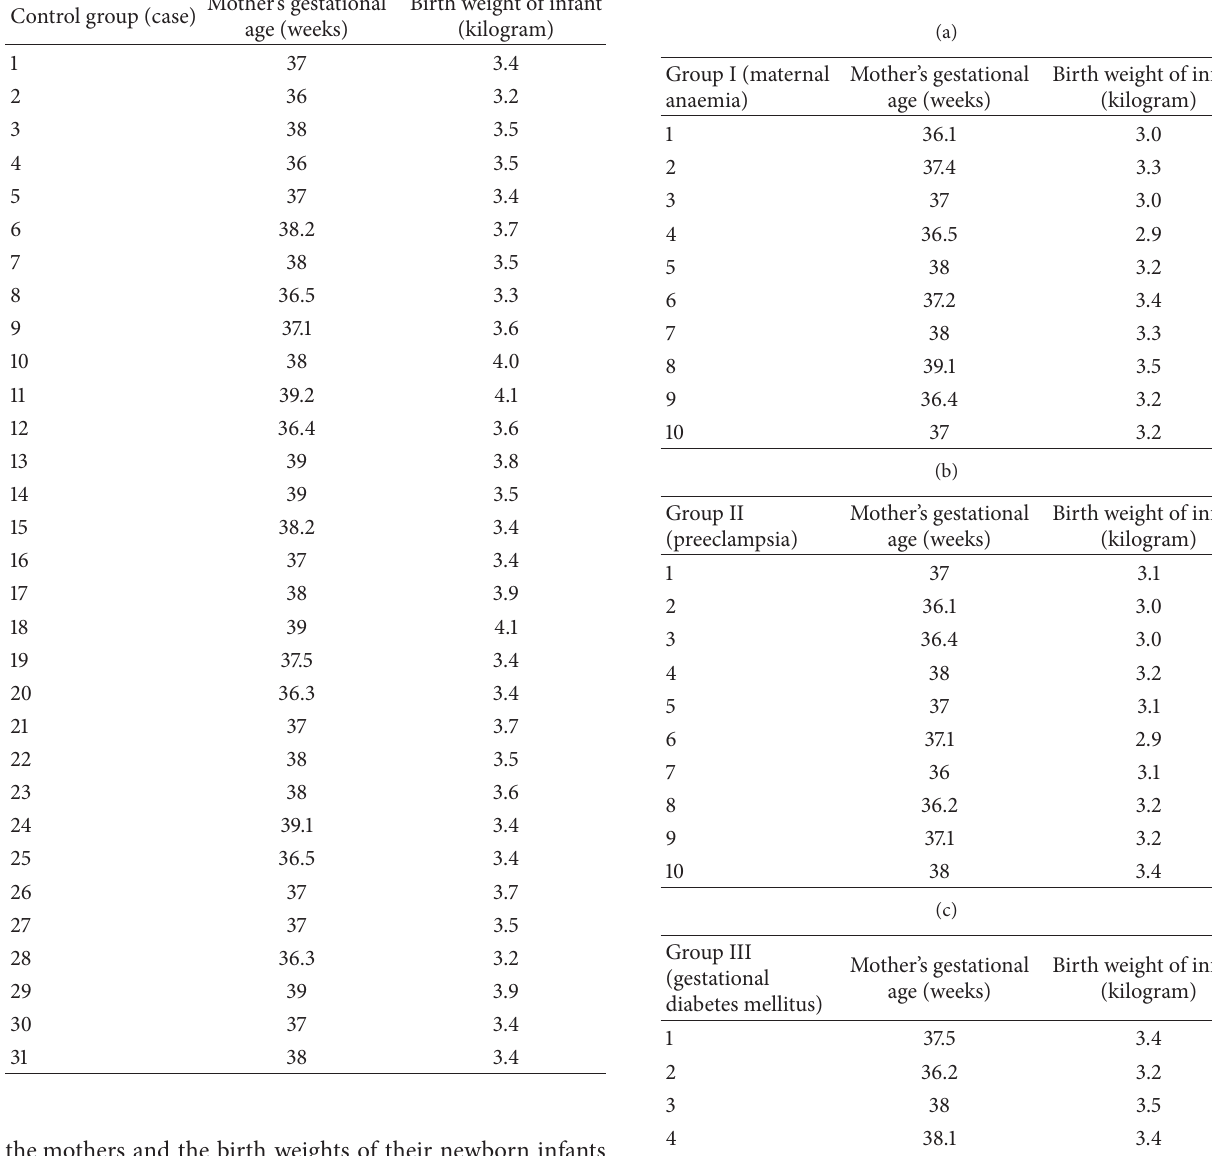
Table 2: Gestational age and birth weight in the various study